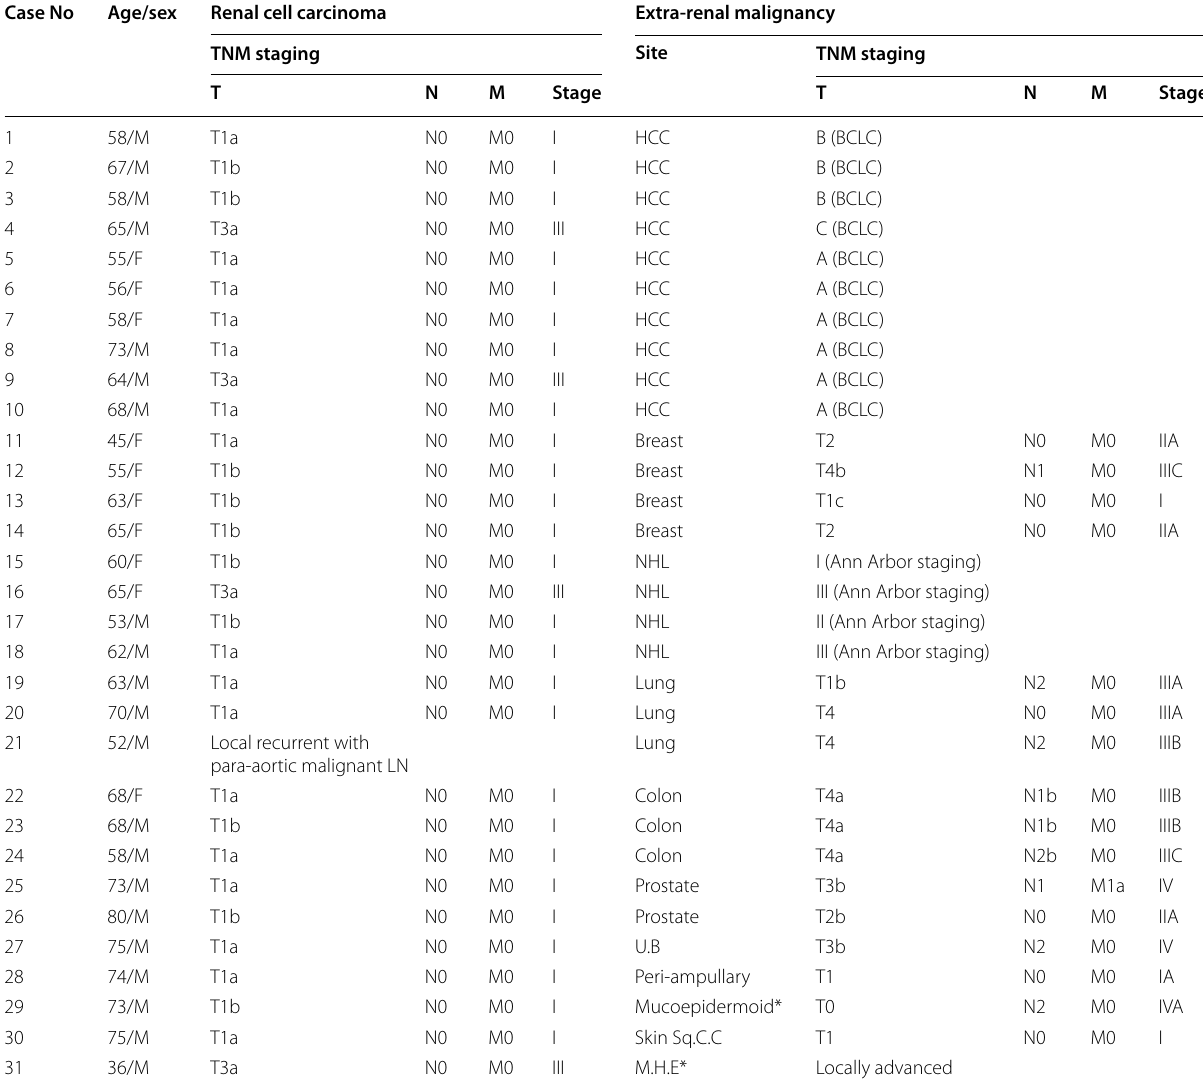
BCLC; Barcelona Clinic Liver Cancer staging classification, HCC; Hepatocellular carcinoma, NHL; Non‑Hodgkin lymphoma, M.H.E*; Malignant hemangioendothelioma, Mucoepidermoid*; Mucoepidermoid carcinoma of left upper cervical region. RCC; Renal cell carcinoma, Sq.C.C.; Squamous cell carcinoma, U.B.; Urinary